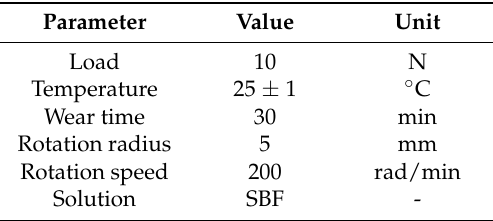
Figure 3. X-ray diffraction (XRD) spectrums of the coatings.